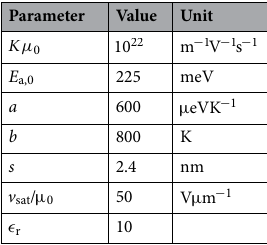
Table 1. Parameters associated with the electrical